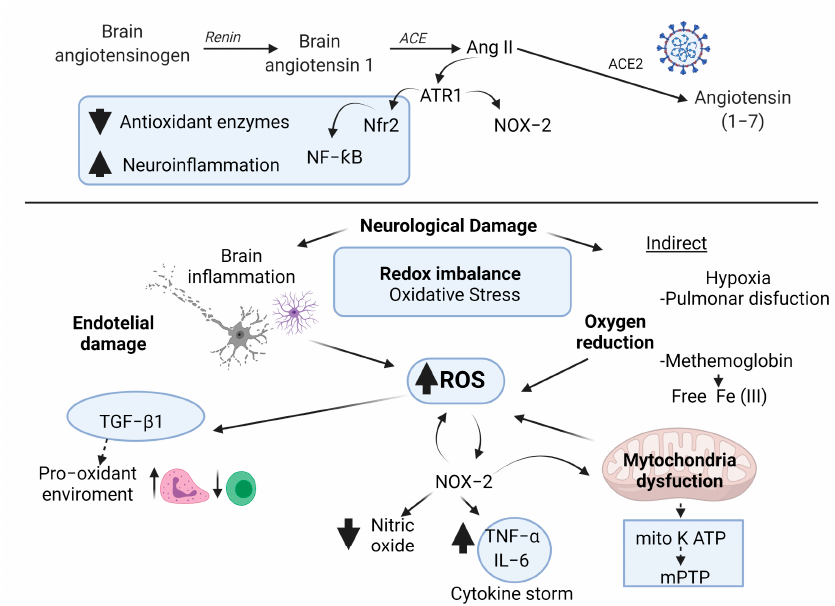
Figure 1. Possible mechanisms of neuronal damage related to redox imbalance in COVID-19. The recruitment of inflammatory cells increases ROS production. ROS levels have been shown to stimu- late inflammatory processes and the release and dissemination of virions. An increase in neutrophils and a decrease in lymphocytes (T cells) has also been related to pro-oxidant environment mediated activation of TGF- β 1. Another major mechanism that could be contributing to the ROS formation is the activation of the NOX-2. NOX-2 activation is regulated by the binding of angiotensin II (Ang II) to angiotensin type 1 (AT1R). The binding of SARS-CoV-2 to ACE2 causes the virus to enter cells and, in turn, reduces the bioavailability of ACE2. The reduction in the bioavailability of ACE2 makes Ang II interact with AT1R, with the subsequent activation of NOX and the induction of oxidative stress and inflammatory responses. NOX activation reduces the bioavailability of nitric oxide. NOX can also be activated by the release of TNF- α during the pro-inflammatory cytokine storm. SARS-CoV-2 attacks the heme groups of hemoglobin in red blood cells, producing the release of free Fe (III) ions into the bloodstream which, through the Fenton and Haber–Weiss reactions, increases the ROS levels. In addition, excess ROS causes the formation of methemoglobin, resulting in less efficient oxygen transport. In the brain, hypoxia causes bioenergetic dysfunction of brain cells, also known as mito- chondrial dysfunction. Cytosolic ROS produced by NOX could trigger the opening of the adenosine triphosphate (ATP)-sensitive mitochondrial potassium channel (mitoK ATP) and the activation of the permeability transition pore (mPTP) causing the depolarization of the mitochondrial membrane and a burst of mitochondrial ROS production and the subsequent mitochondrial dysfunction. TNF- α and interleukin (IL)-6 impair mitochondrial oxidative phosphorylation and coupled ATP production and trigger the production of mitochondrial ROS in the cell, leading to mitochondrial dysfunction. Respiratory viral infections have been associated with inhibition of nuclear erythroid factor 2-related factor 2 (Nrf2) and activation of NF- κ B. The decrease in Nrf has been related to a detriment in the production of antioxidant enzymes.